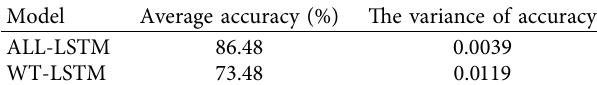
Table 5: Comparison of results of the two classification models. Model Average accuracy (%) The variance of